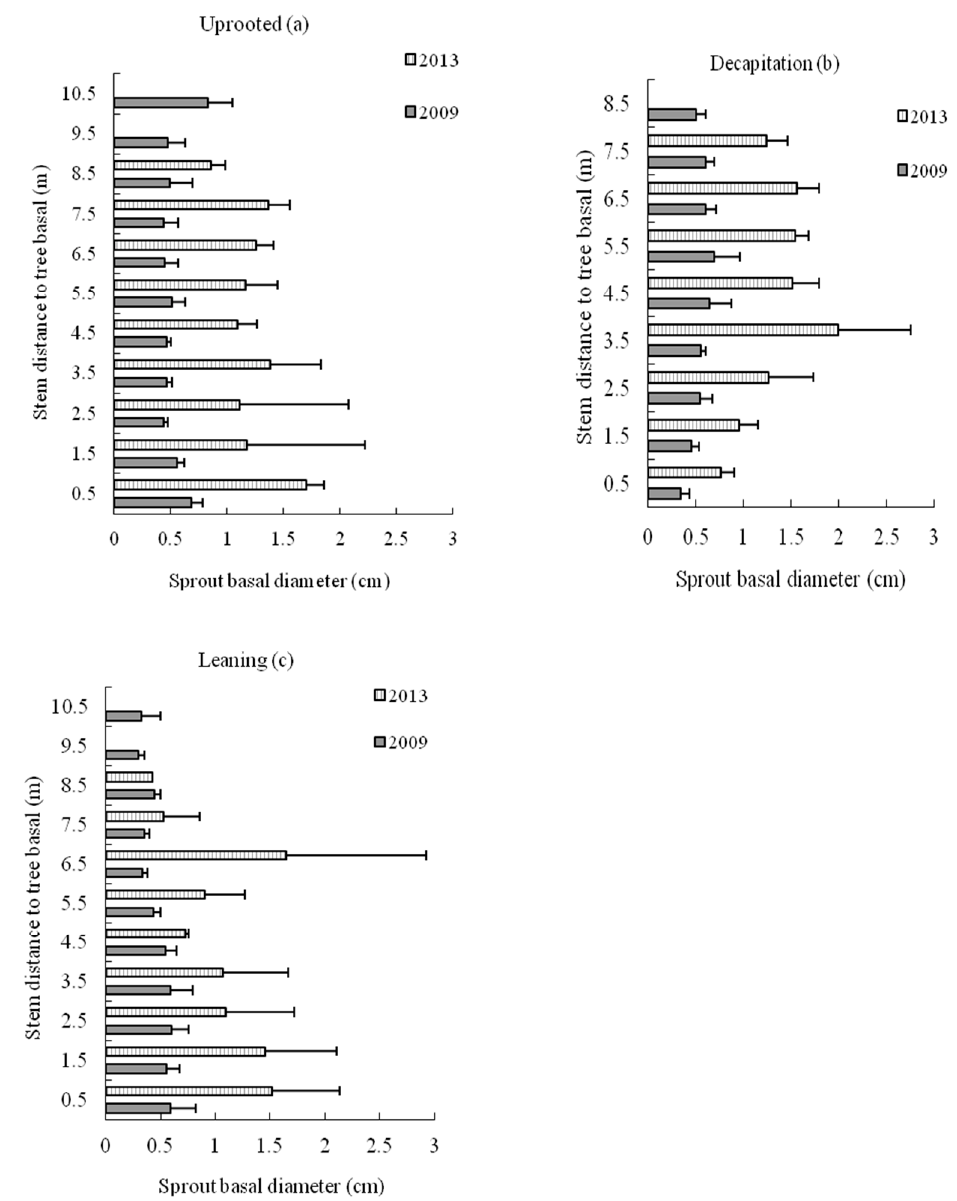
Figure 8. The sprout basal diameter distribution on stems ( a ) uprooted, ( b ) decapitation and ( c ) leaning trees of S. superba in 2009 and 2013, respectively.